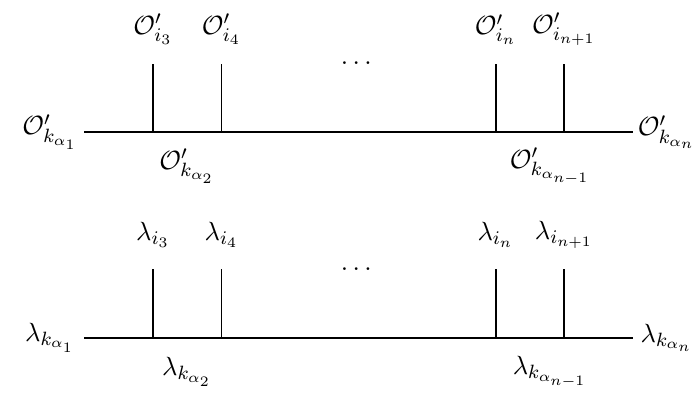
Figure 19 . The final comb structure after evaluating the λ i